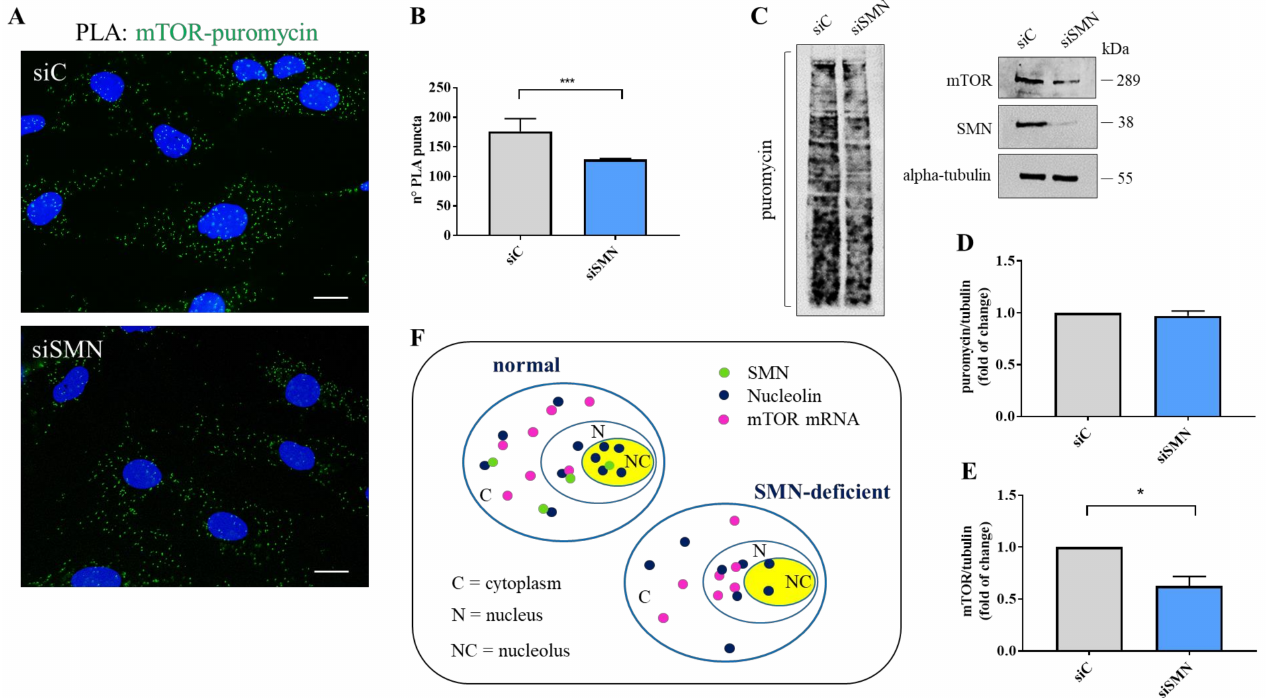
Figure 5. SMN knockdown reduces neo-synthesis of mTOR. ( A ) Puro-PLA assay was carried out using primary antibodies against puromycin and mTOR (mouse monoclonal and rabbit polyclonal, respectively). Representative images visualizing the subcellular distribution of newly synthesized mTOR protein (green dots) in both siC- and siSMN-transfected fibroblasts. Nuclei were stained with DAPI (blue). Scale bars, 10 µ m. ( B ) Quantitative analysis of Puro-PLA puncta per cell ( n = 20 cells were analysed for each sample. *** p < 0.0001 one-way ANOVA–Bonferroni’s multiple comparisons test (Mean ± s.d.; n = 3) ( C ) Evaluation of protein synthesis rate by SUnSET assay of both siC- and siSMN-transfected fibroblasts. Equal amounts of proteins were immunoblotted with the indicated antibodies. ( D ) Densiometric analysis of puromycin normalized to tubulin. No statistically significant changes are observed in hTERT-fibroblast transfected with siSMN1 siRNA (siSMN) compared with hTERT-fibroblast transfected with the control (siC). (Mean ± s.d.; n = 3; Student’s t -test.) ( E ). Densiometric analysis of mTOR normalized to tubulin. Statistically significant changes occurring in SMN-depleted cells (siSMN), compared to the control (siC). (Mean ± s.d.; n = 3; * p = 0.01, Student’s t -test). ( F ) Graphical representation for the mechanism by which SMN fine-tunes nucleolin and mTOR mRNA